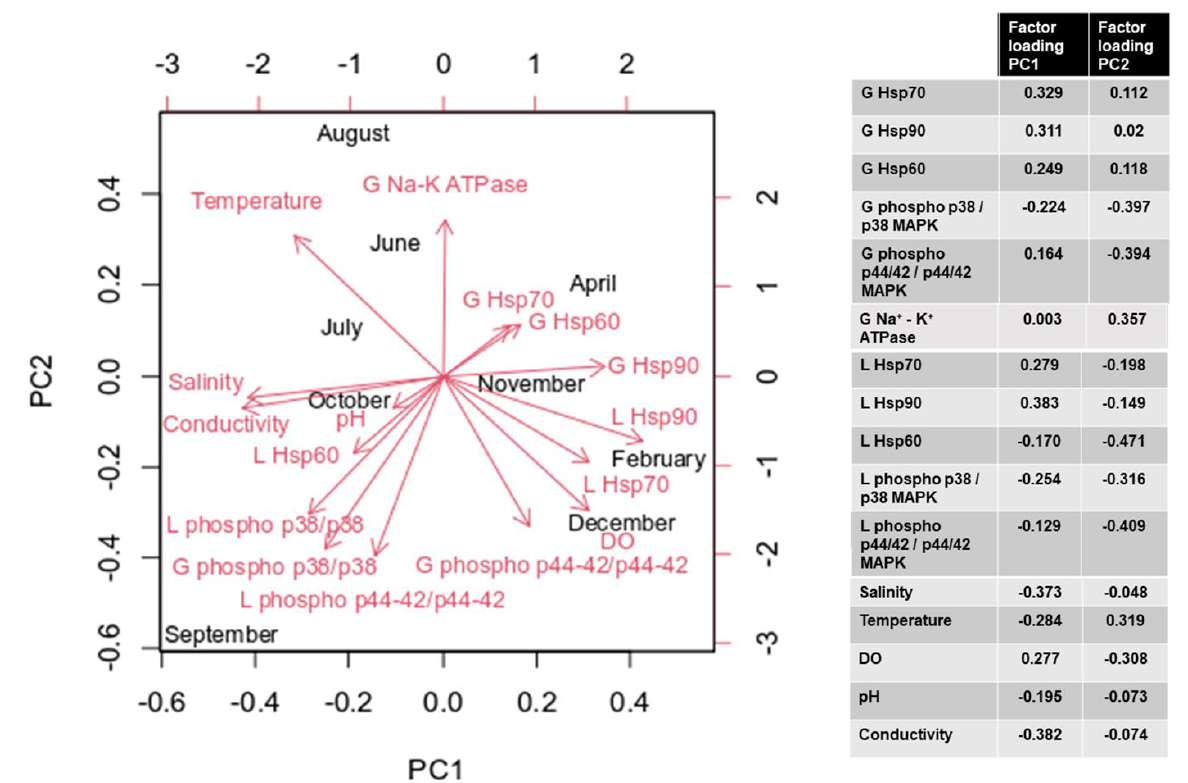
Figure 7. Principal Component Analysis biplot of the CSR biomarkers (G = gills, L = liver) measured in Alburnus vistonicus ( n = 45, 5 fish per month) and mean values of the physico-chemical parameters measured in Vistonis Lake (northern Greece) during the sampling period (October 2014–September 2015). In the inserted table the factor loadings of each parameter on the two principal components (PC1 and PC2) are presented.